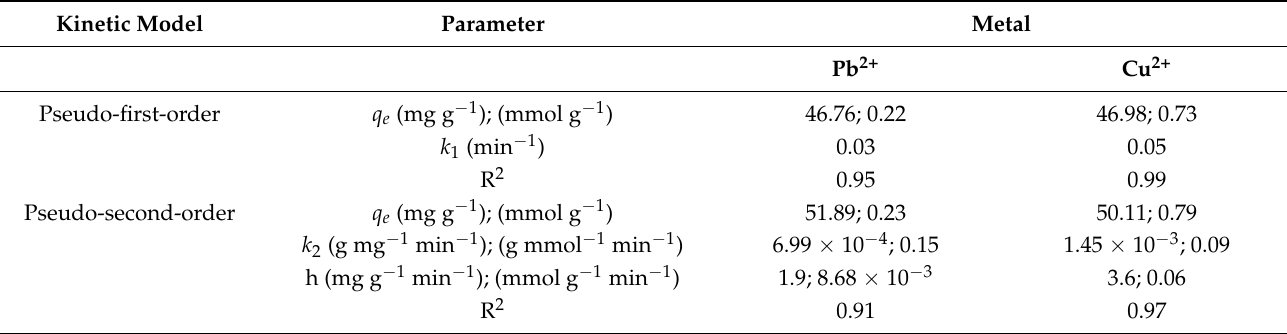
Figure 2. Adsorption kinetics of Pb 2+ and Cu 2+ ( a ) in mg g −1 and ( b ) in mmol g −1 onto PAM@MNP fitted to pseudo-first-order and pseudo-second-order models. Adsorbent concentration: 0.2 g L −1 ; initial metal concentration: 10 mg L −1 ; pH: 6; temperature: 20 °C. Table 1. Parameters of pseudo-first-order and pseudo-second-order kinetic models for Pb 2+ and Cu 2+ adsorption onto PAM@MNP.